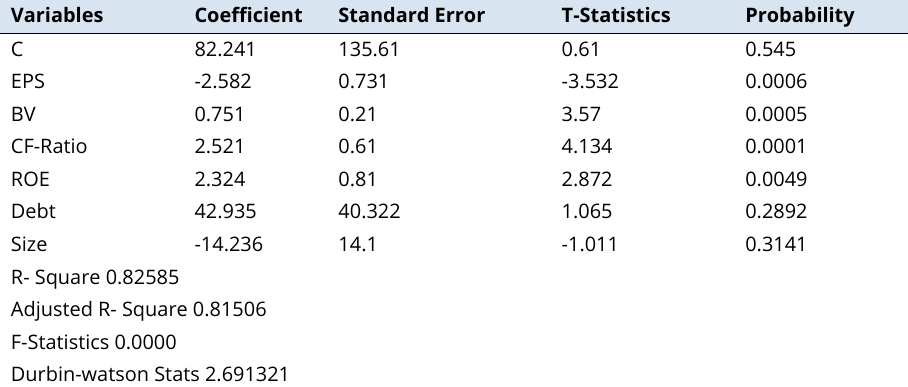
Fixed Effect Model-PRE